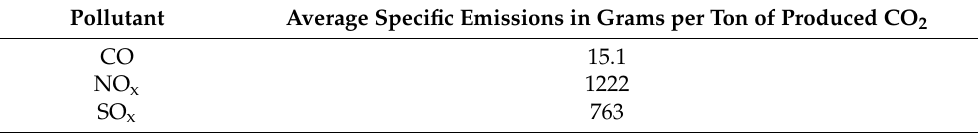
Table 5. Average specific emissions of pollutants in grams per ton of produced CO 2